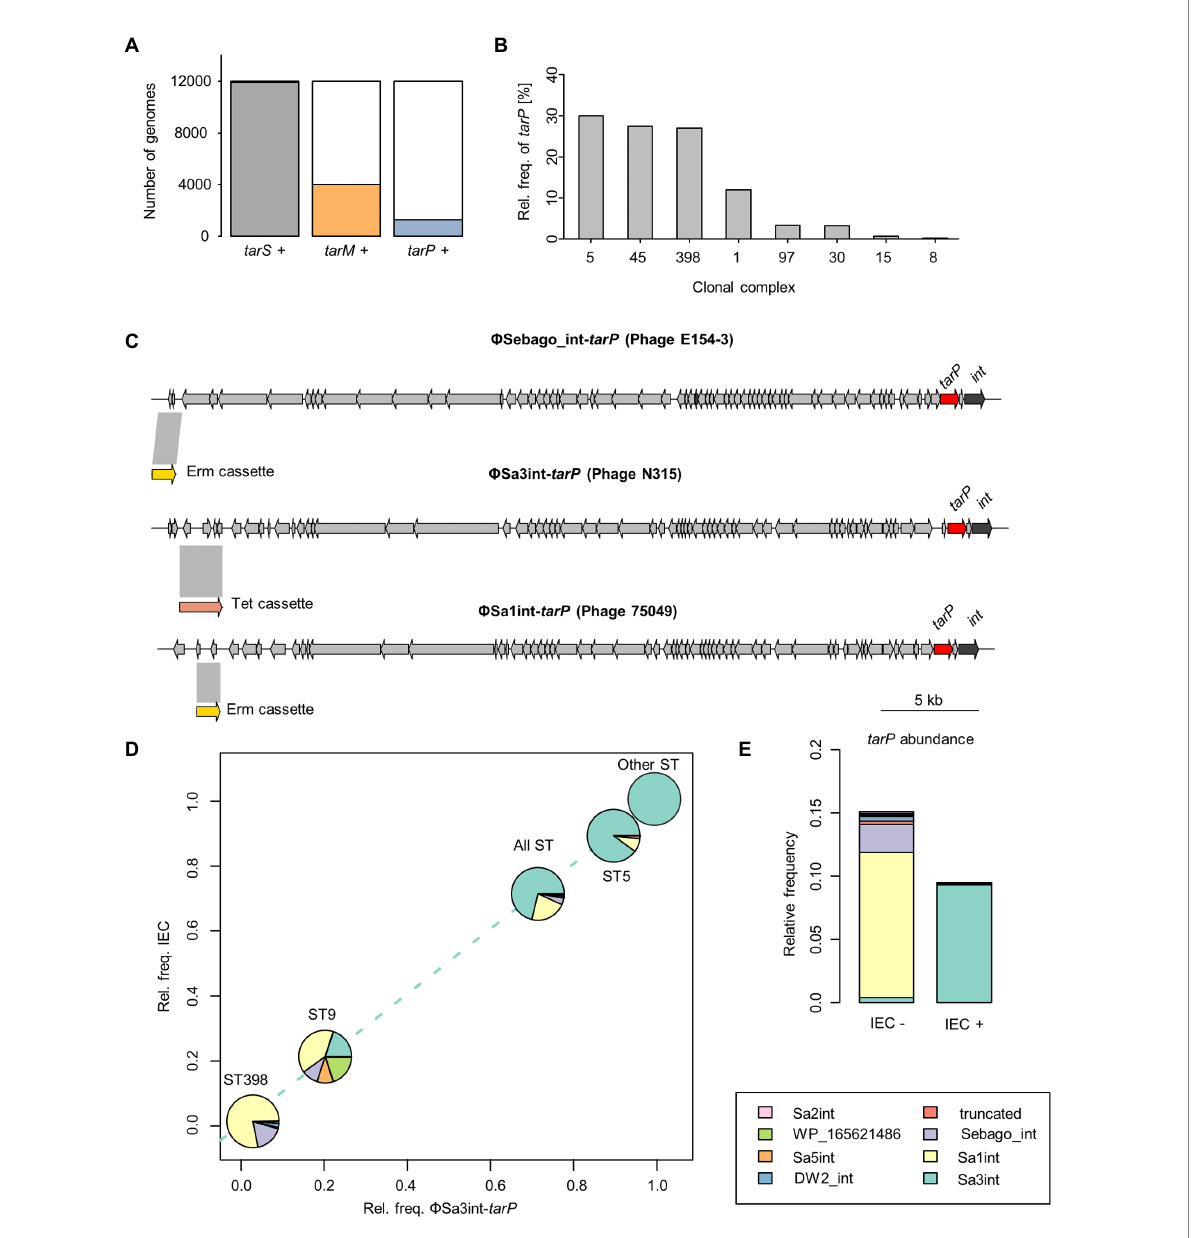
FIGURE 1 Distribution of tarP phages across Staphylococcus aureus isolates. (A) Absolute frequency of RboP WTA glycosyltransferases (GT). (B) Relative frequency in percent of tarP in clonal complexes. Clonal complexes were used to summarize ST. (C) Genetic structure of manipulated tarP phages, presented in this work, indicating location of tarP , integrase (red) and the respective, inserted antibiotic resistance marker (yellow/pink). (D) tarP phage distribution of main tarP -encoding ST (other STs comprise 45, 180, 188, 225, 228, and 3,410). Each ST is placed according to its relative frequencies of IEC and Sa3int- tarP phages. (E) Relative frequency of tarP in relation to IEC. tarP -associated phage integrases are indicated by the same colours as in panel D